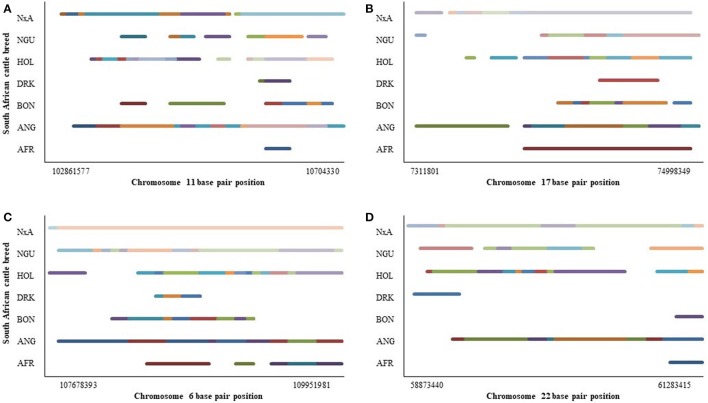
CNV chromosomal distribution in seven cattle breeds at four different chromosomal locations namely (A) chr11:102861577-10704330, (B) chr17:7311801-74998349, (C) chr6:107678393-109951981, and (D) chr22:58873440-61283415.